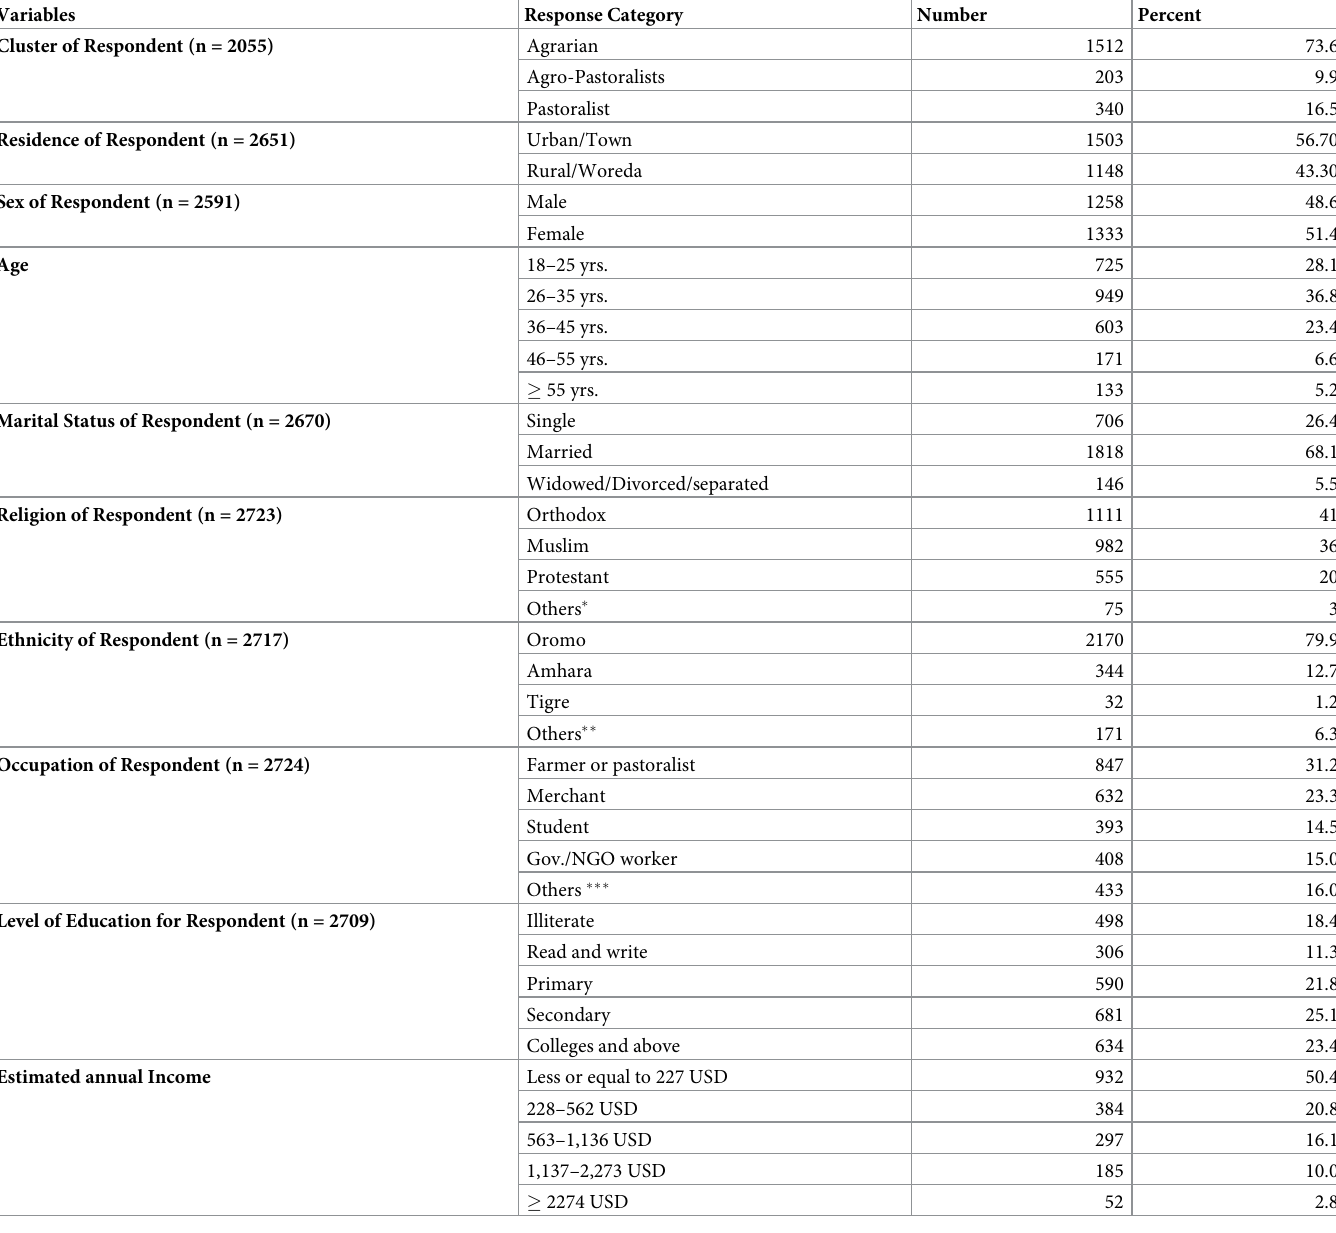
Table 2. Socio-demographic characteristics of the respondents, Oromia region, Ethiopia, September 2020 to March